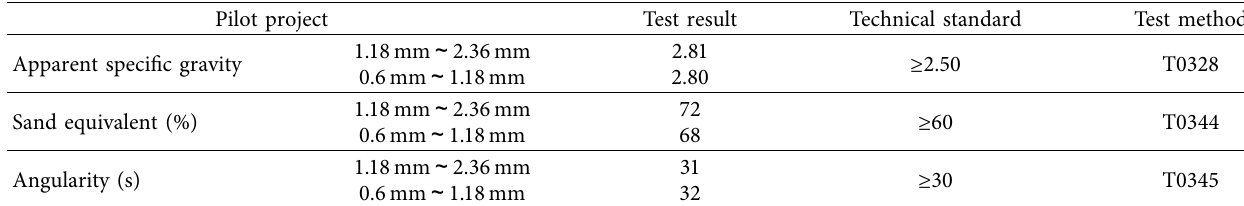
Table 3: Main technical index of fine